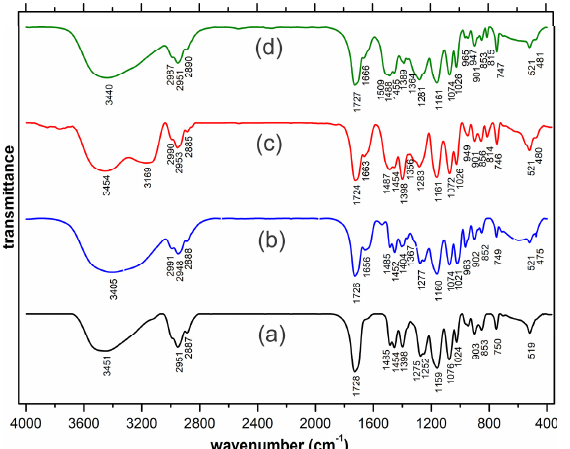
Figure 2. Spectra FT-IR spectra were recorded for: ( a ) HEMA ligand, ( b ) La(III), ( c ) Eu(III), and ( d ) Tb(III) aerogels.